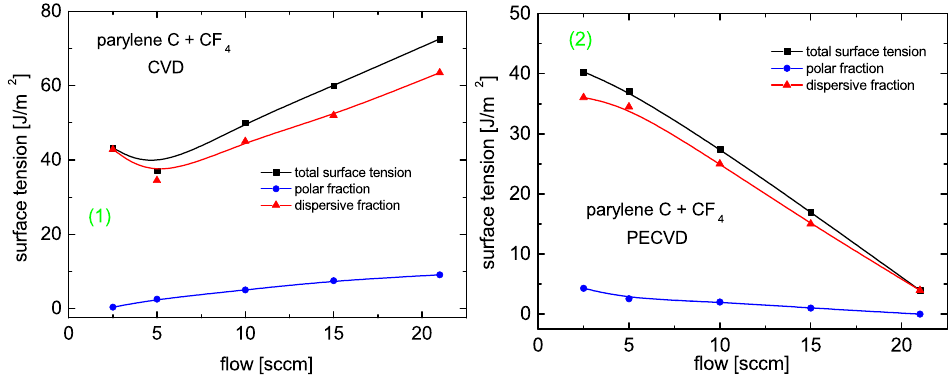
Figure 34. Different habits of the surface tension of CVD parylene C ( 1 ) and PECVD parylene C ( 2 ), doped with CF 4 . Microwave power was between 100 and 125 W.